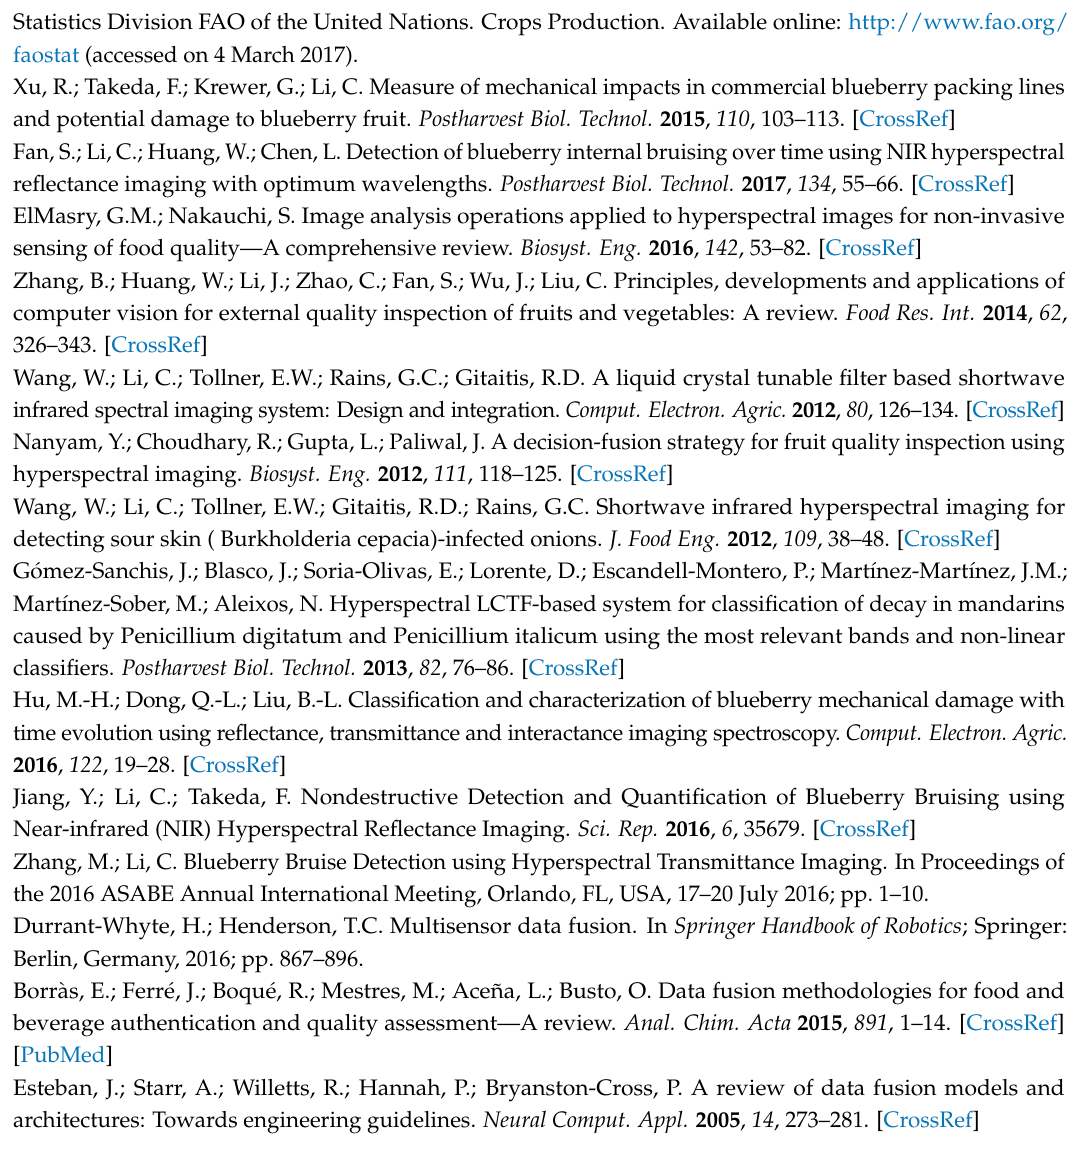
Figure S1: PLS-DA probability output. Figure S2: False negative rate of stem, equator, and calyx bruise groups obtained by (a) PLS-DA and (b) SVM analysis based on the mean reflectance from push broom based and LCTF based HSI. Figure S3: Mean reflectance of stem, equator, and calyx bruise collected by (a) push broom based and (b) LCTF based HSI. Figure S4: The classification error of 10-fold cross validation calculated by the PLS-DA for the features generated by random frog from (a) push broom based and (b) LCTF based hyperspectral data, and (c) their fused data. Table S1: Number of blueberries used in HSI